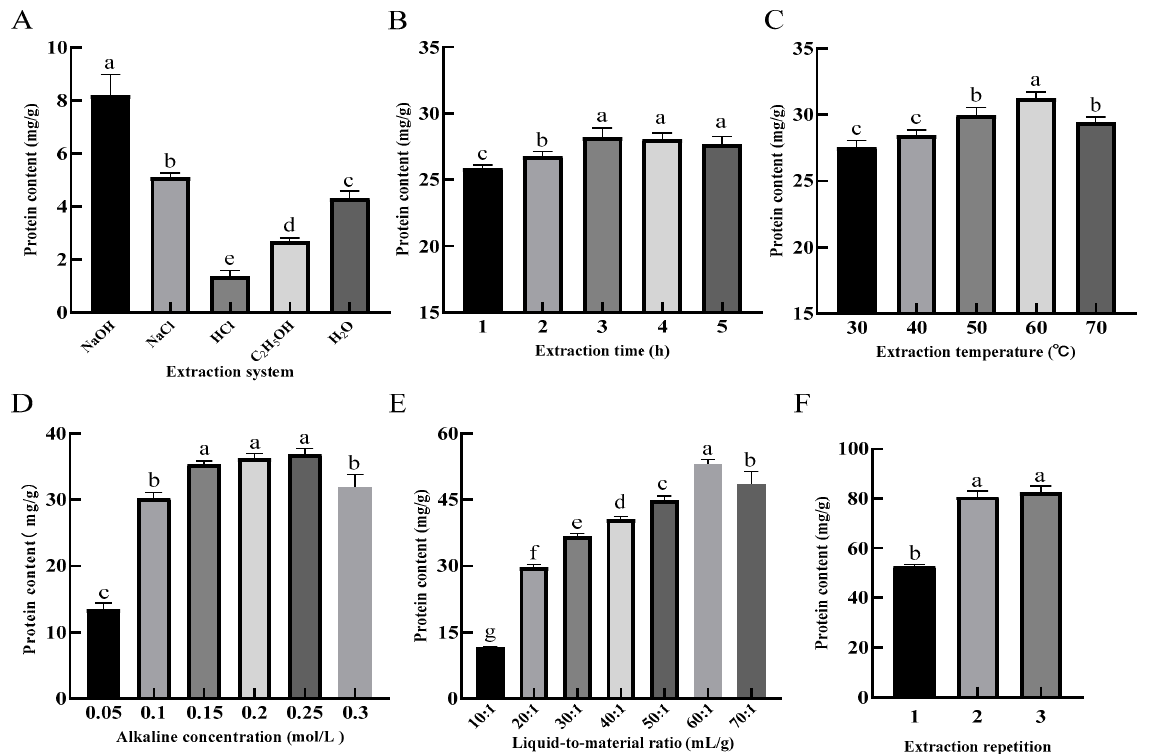
Figure 2. Effects of extraction system ( A ), extraction time ( B ), extraction temperature ( C ), alkaline concentration ( D ), liquid-to-material ratio ( E ) and extraction repetition ( F ) on the extraction rate of protein. Different lower-case letters in the column charts indicate a significant difference at p < 0.05.